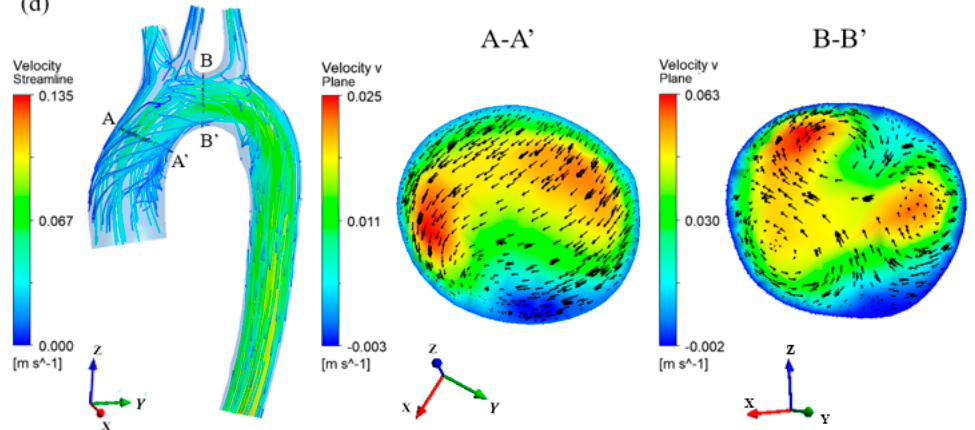
Figure 6. Velocity distributions with y-direction velocity vectors without any projection at two different time points (0.4 s and 0.6 s) and two different cross-sections (A-A’ and B-B’) in the half-moon and crescent pulmonary grafts: ( a ) half-moon graft at 0.4 s, ( b ) half-moon graft at 0.6 s, ( c ) crescent graft at 0.4 s, and ( d ) crescent graft at 0.6 s.